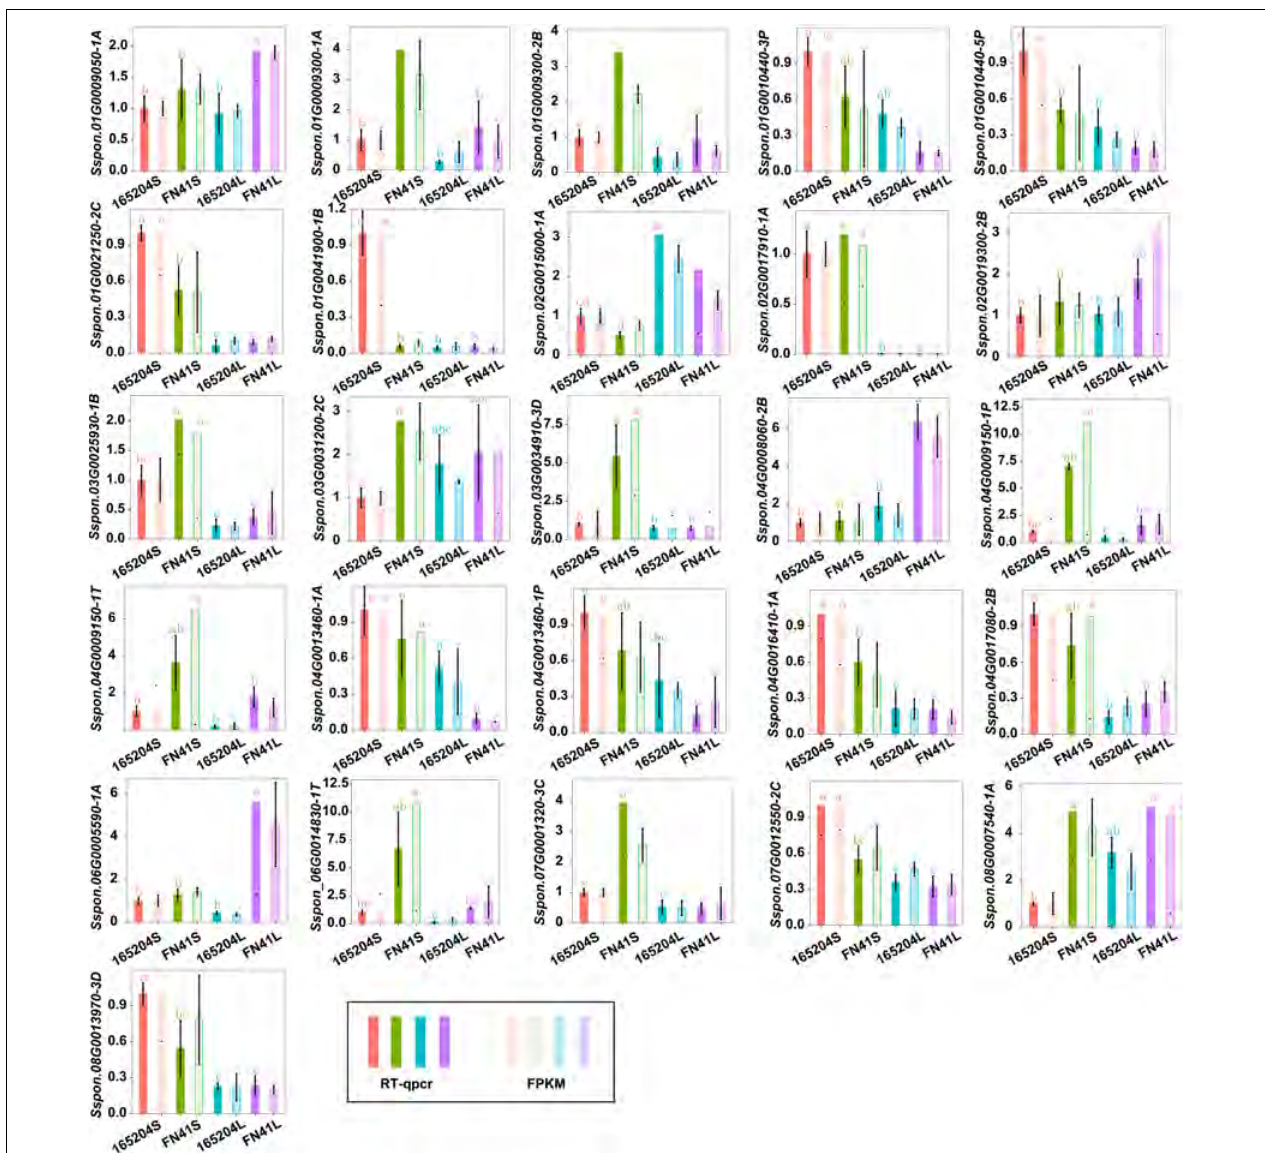
FIGURE 6 | RT-qPCR analysis showing the significance level of various genes identified in the different tissues of cane.